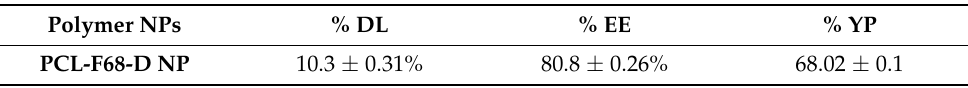
Table 2. Diosgenin loading, encapsulation efficiency, and yield of production of formulated nanopar-